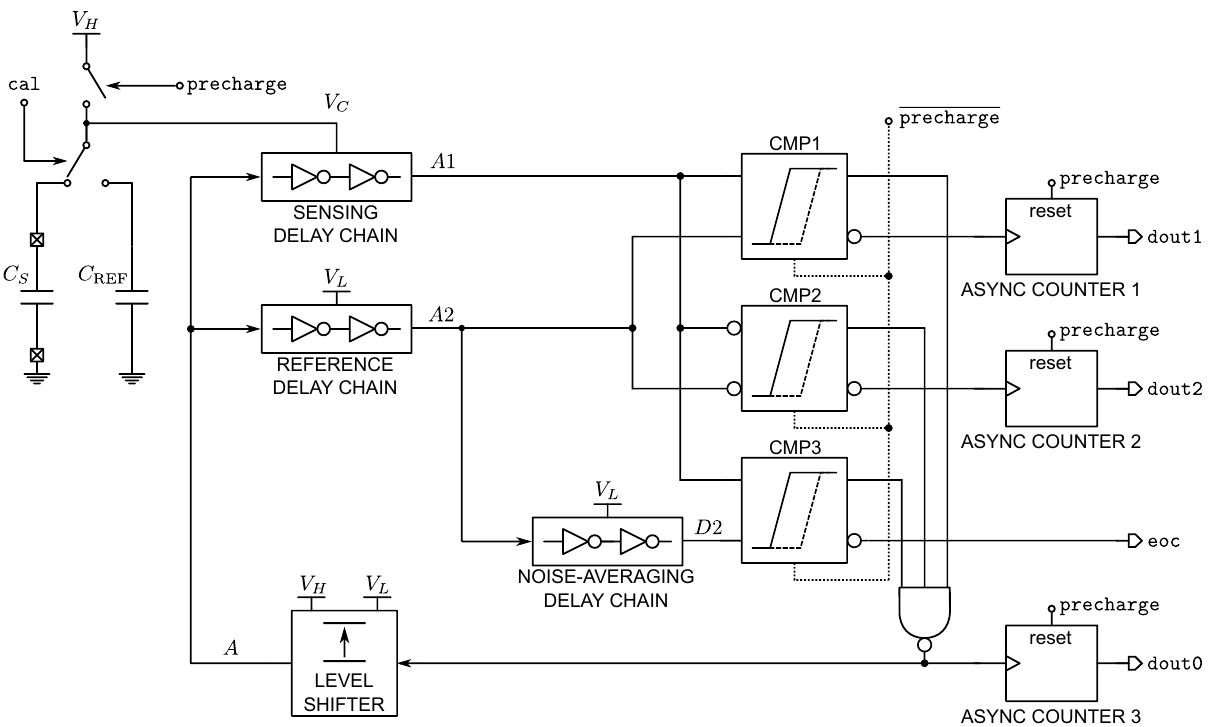
Figure 6. Complete CDC schematic including time-delay comparator-noise averaging and the one- point calibration